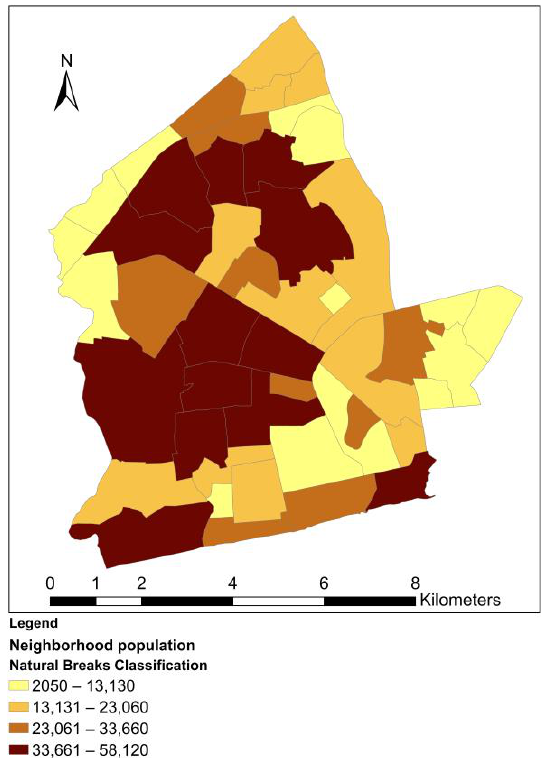
Figure 5. Distribution of neighborhood population.